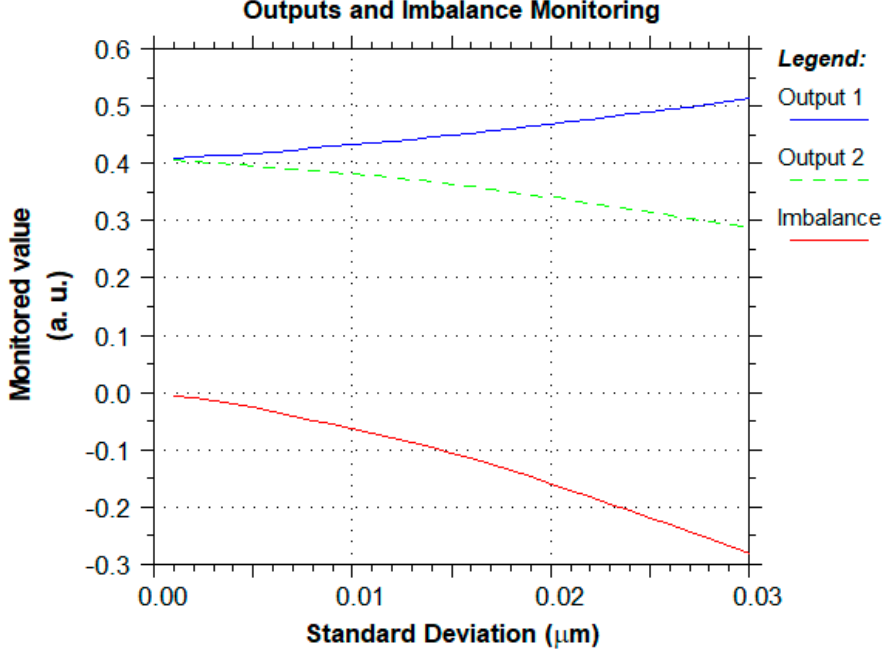
Figure 3. Resulting imbalance due to limited lithographic mask resolution.